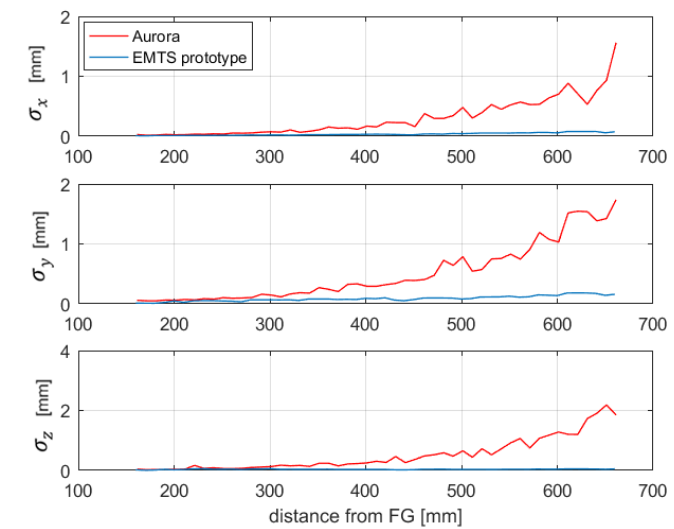
Figure 13. Comparison between the SD of the Aurora system and the EMTS prototype obtained along the trajectory “aq.2”.